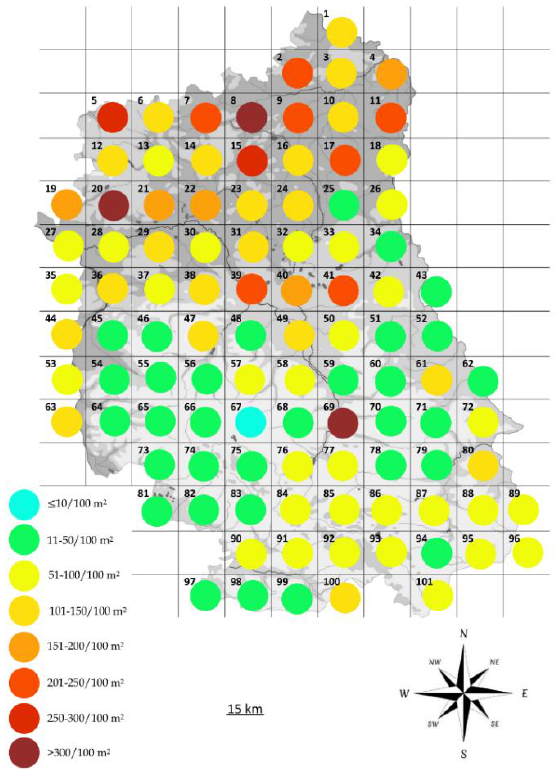
Figure 6. Spatial distribution of the average density of D. reticulatus populations in Lublin Province, the map outline based on Wikimedia [42] with our own modifications.